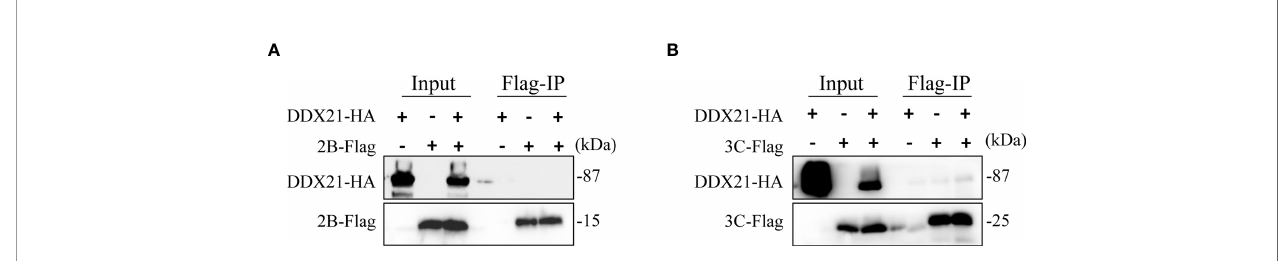
FIGURE 6 | DDX21 does not interact with SVA 2B and 3C protein. (A) HEK293T cells were cotransfected with HA-DDX21 and 2B-Flag. (B) HEK293T cells were cotransfected with HA-DDX21 and 3C- fl ag. Coimmunoprecipitation (Co-IP) was performed using agarose beads conjugated with anti-Flag mAb agarose beads. Precipitated proteins were analyzed by WB using antibodies against the Flag and HA.